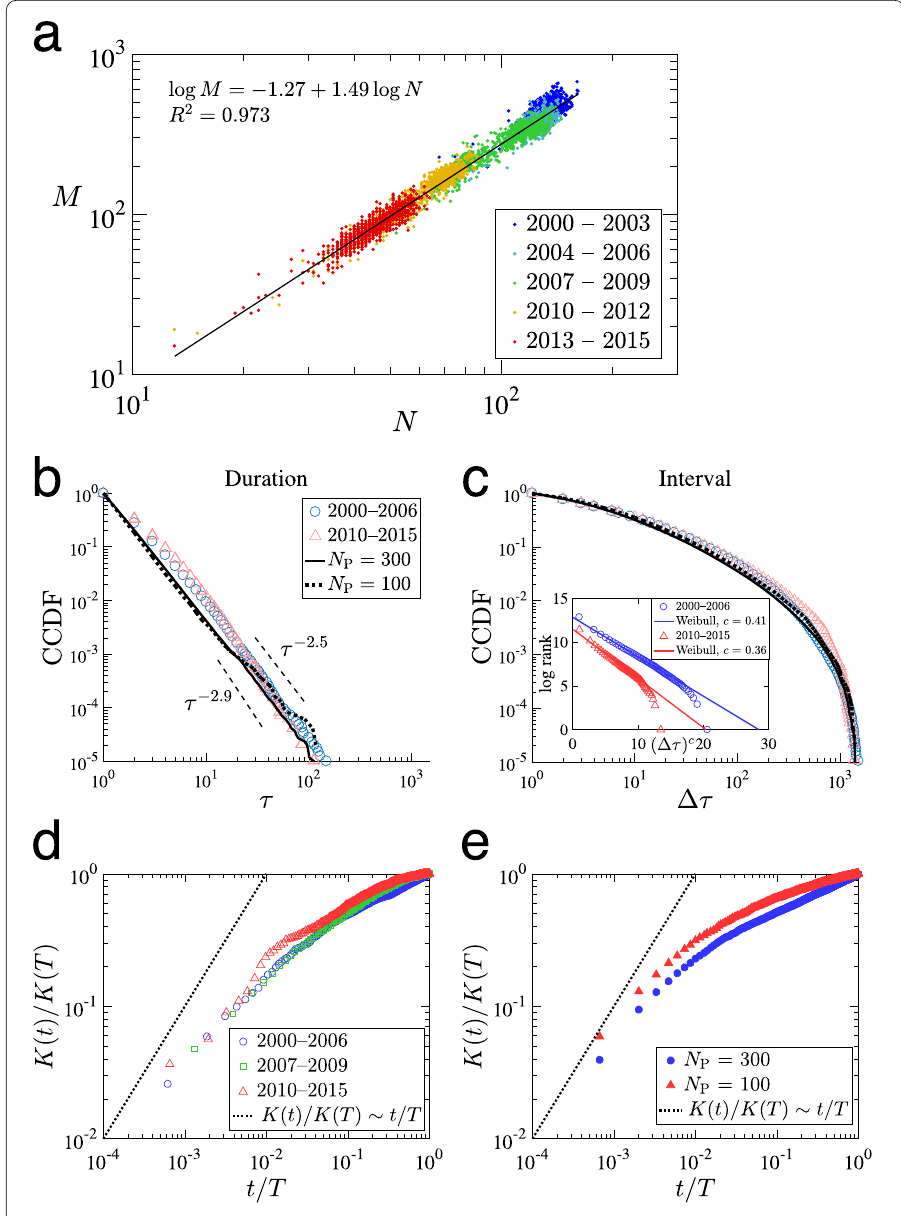
Figure 2 Dynamical patterns of daily networks. ( a ) M is a power-law function of N . A dot corresponds to a daily network, and solid line represents a log-linear regression estimated by the ordinary least squares. ( b ) Distribution of consecutive trading days, τ , for a bank pair, aggregated over all pairs. Blue circles and red triangles indicate the empirical distributions for 2000–2006 and 2010–2015, respectively. Solid and dotted lines represent simulated distributions with N P = 300 and 100, respectively. ( c ) Distribution of interval time, (cid:4)τ , between two consecutive transactions for a bank pair, aggregated over all pairs. Inset : log-rank plot of ( (cid:4)τ ) c indicated by a Weibull distribution with estimated parameter c (symbols), and its theoretical values (lines). ( d ) Time series of the empirical aggregate degree K ( t ) (averaged over all banks) normalized by its terminal value K ( T ) and ( e ) the simulated aggregate degree